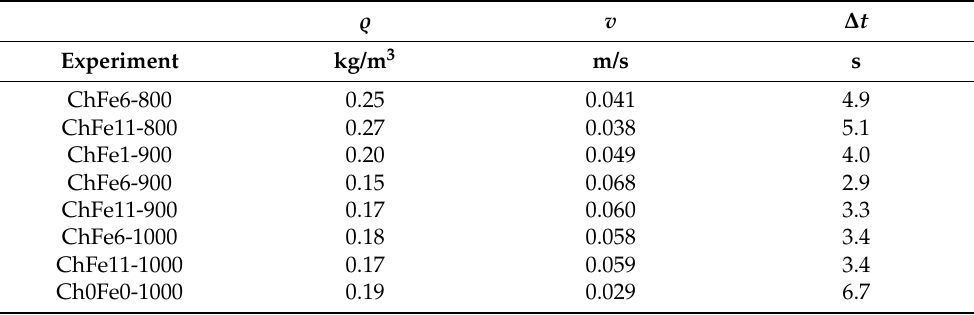
Table 5. Gas density, velocity, and residence time in experiment series.